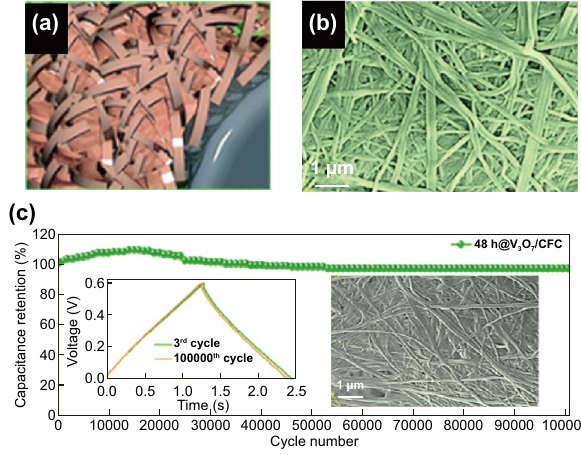
Fig. 4 a Schematic representation of the in situ growth of V 3 O 7 spi- der web-like nanowires, b SEM image V 3 O 7 /CFC substrates. c Cycling stability of V 3 O 7 /CFC SSCs devices at a constant current density of 10 A g –1 for 100,000 cycles. Reproduced with permission from Ref. [118]. Copyright 2018, Royal Society of